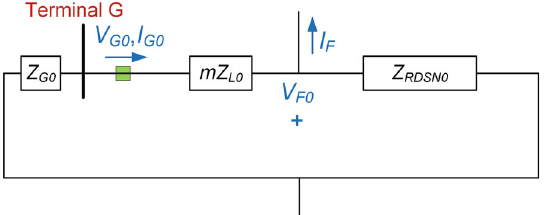
Fig. 9 Zero-sequence network of a general transmission line network during a ground fault